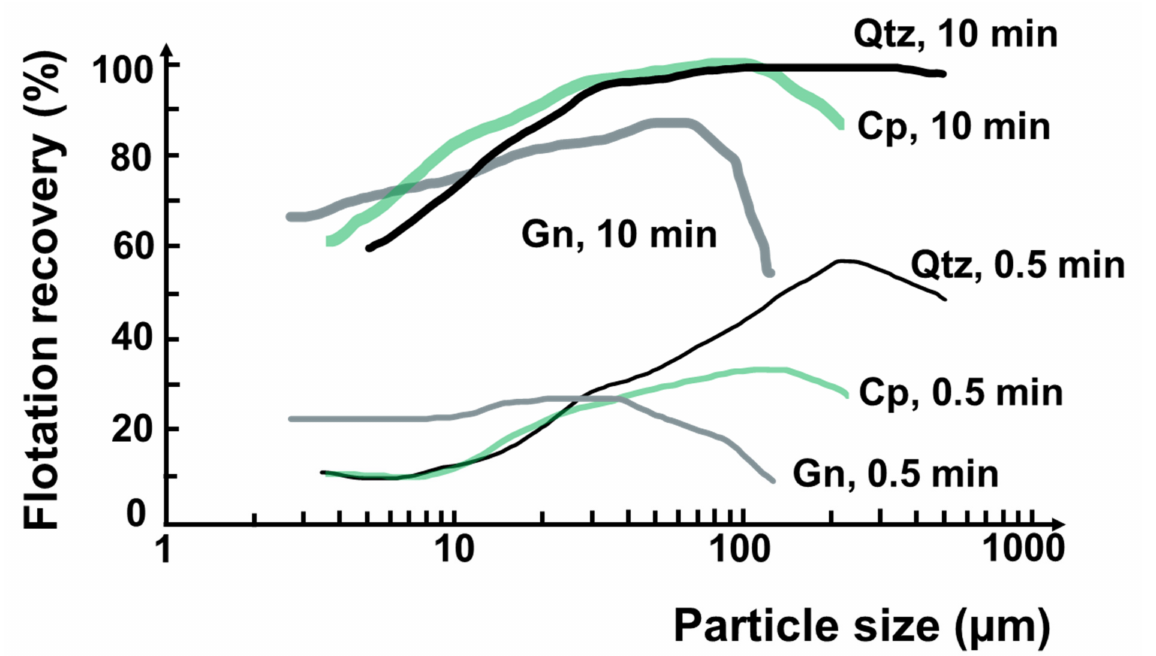
Figure 2. Flotation recovery of different mineral particles at 0.5 and 10 min. Qtz, Cp and Gn refer to quartz, chalcopyrite, and galena, respectively. Redrawn and adapted from